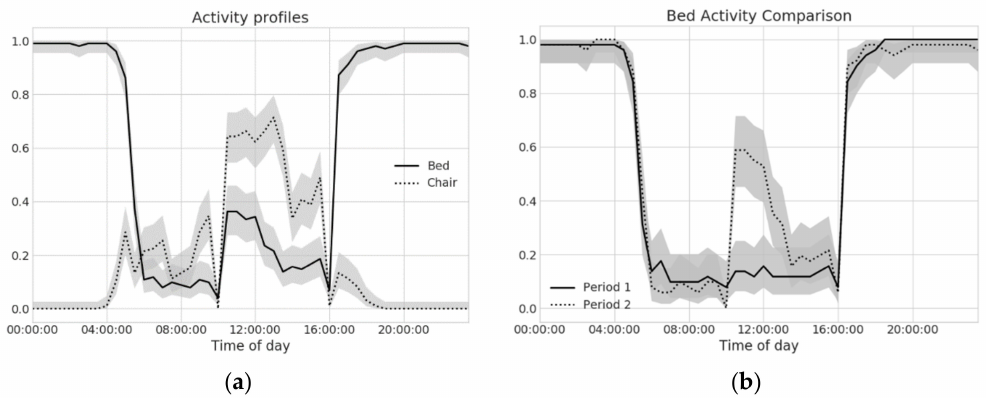
Figure 4. ( a ) Sensor profiles for bed and chair sensors. The shaded area represents the 95% confidence interval of the estimated sensor profile values; and ( b ) a comparison of bed SP for two consecutive periods (20 days each). Non-overlapping confidence intervals indicate statistically significant differences, indicating underlying behavioral changes. In this case, bed presence is significantly increased right after lunch (time in